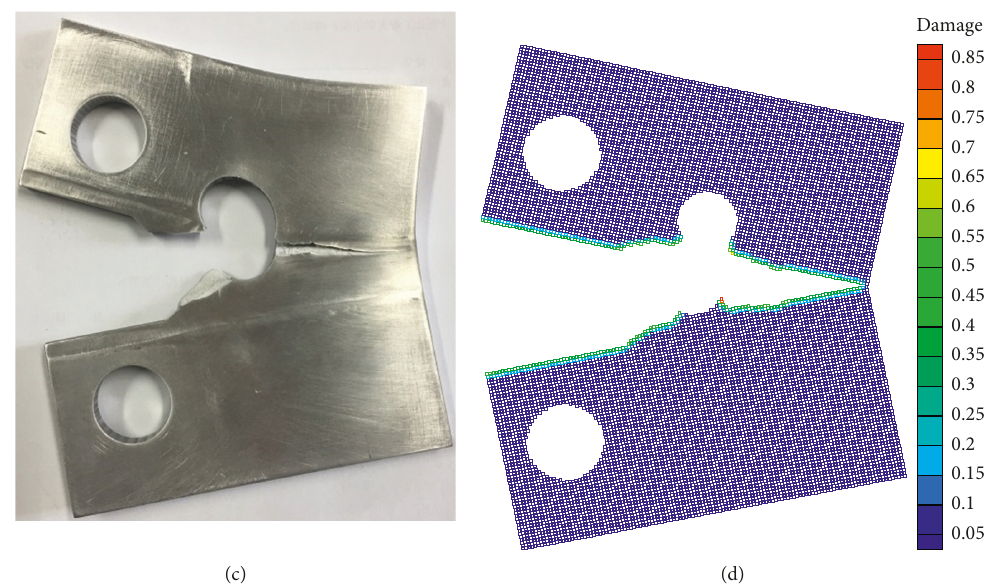
Figure 6: Quasistatic crack path comparison. (a) Experimental crack path of sample 1. (b) Peridynamic crack path of sample 1. (c) Experimental crack path of sample 2. (d) Peridynamic crack path of sample 2.